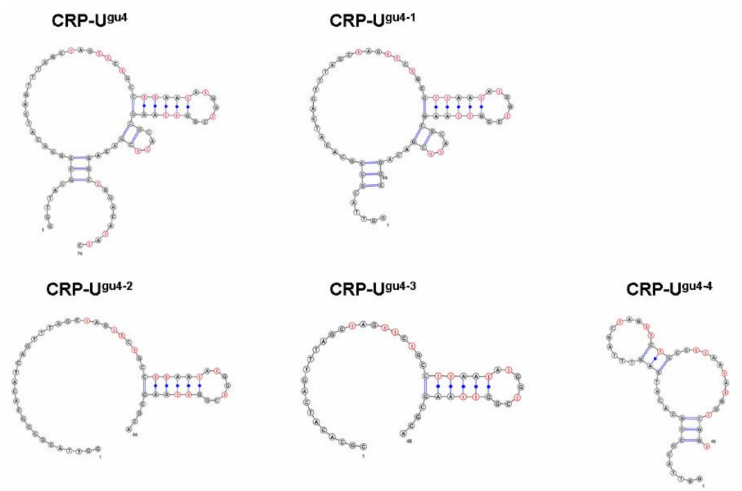
Figure A6. SPR response curve of the interaction between either LDH-5 or LDH-1 and the candidate aptamers LDH–U ad1 , U gu3 , and A ad1 . LDH-5 or LDH-1 (400 nM each) were injected over the respective aptamer-immobilizing sensor chips for 120 s at a flow rate of 50 µ L / min. The red line represents the LDH-5 measured curve, while the gray line represents the LDH-1 recorded curves.